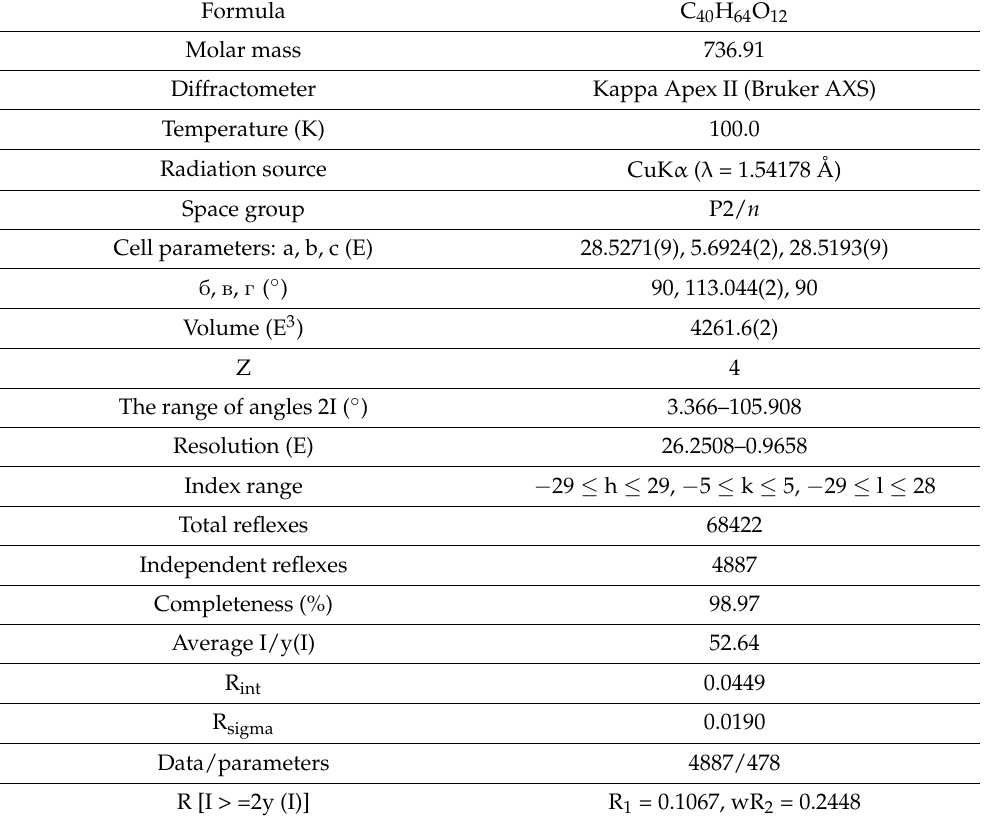
Table 4. X-ray data acquisition and processing